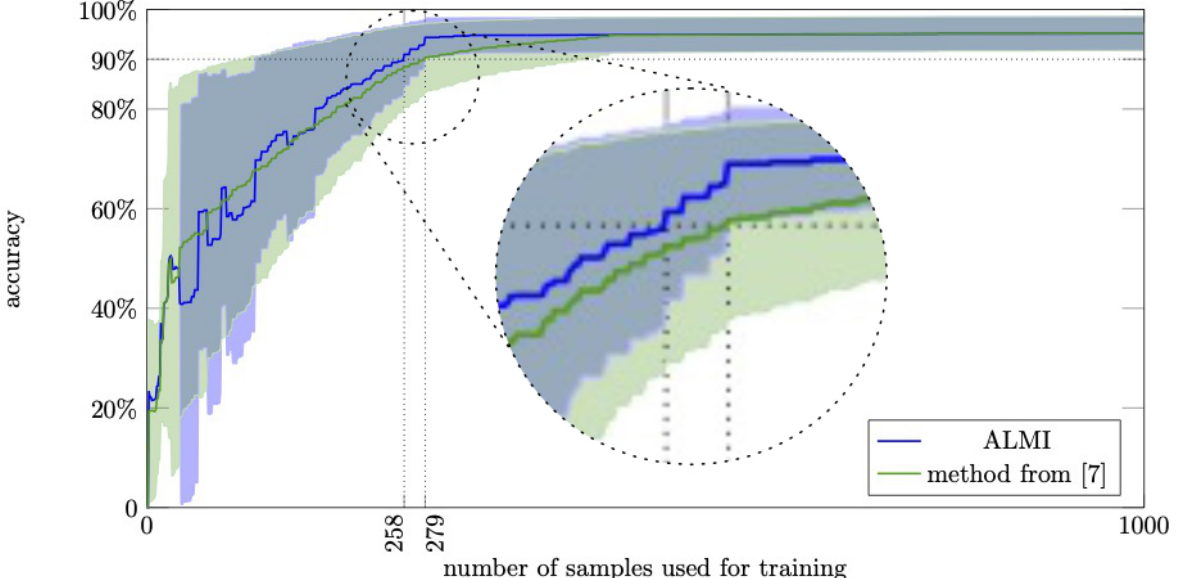
Figure 7. The accuracy values according to Equation (17) for ALMI (blue) and the method proposed in [7] (green) achieved on the dataset LV. The blue and green areas visualize the standard deviation as computed in Equation (19). The circle shows a magnification of the plots in the region around the 90% accuracy mark. The vertical straight lines show how many labels are required to achieve a performance of